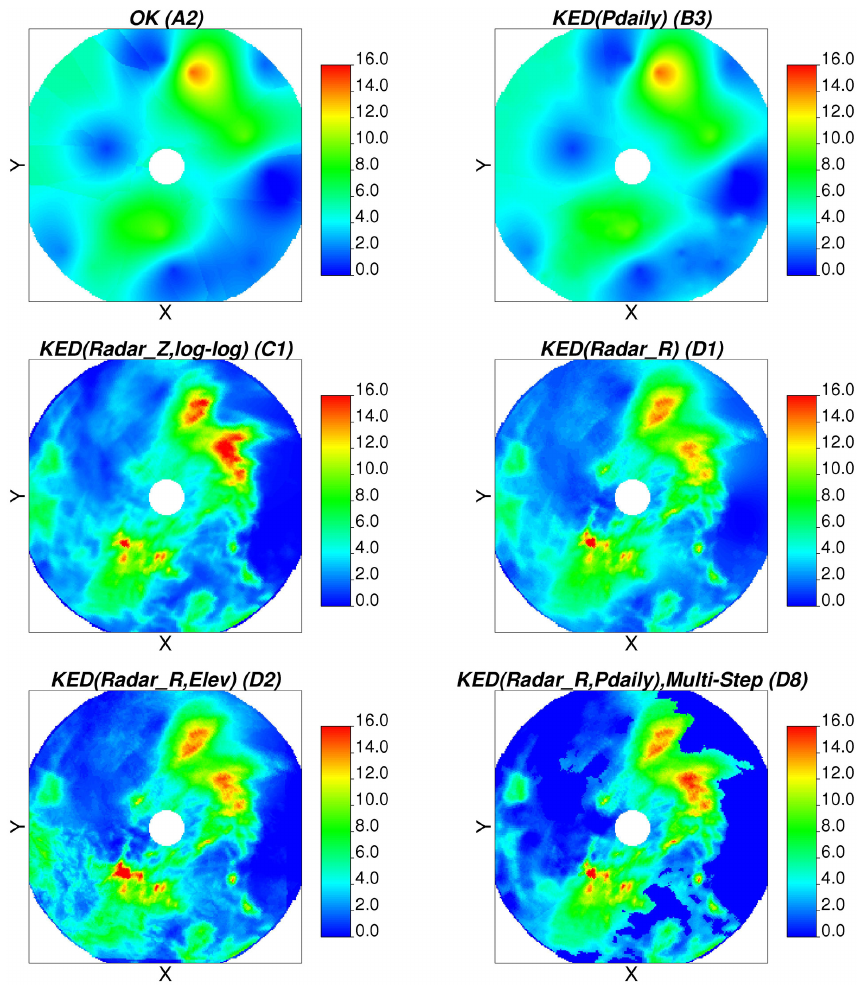
Fig. 9. Spatial distribution of precipitation in mm/h for one hour between 06:00p.m. and 07:00p.m. on the 17 July 2002 interpolated with different methods (variant number see Table